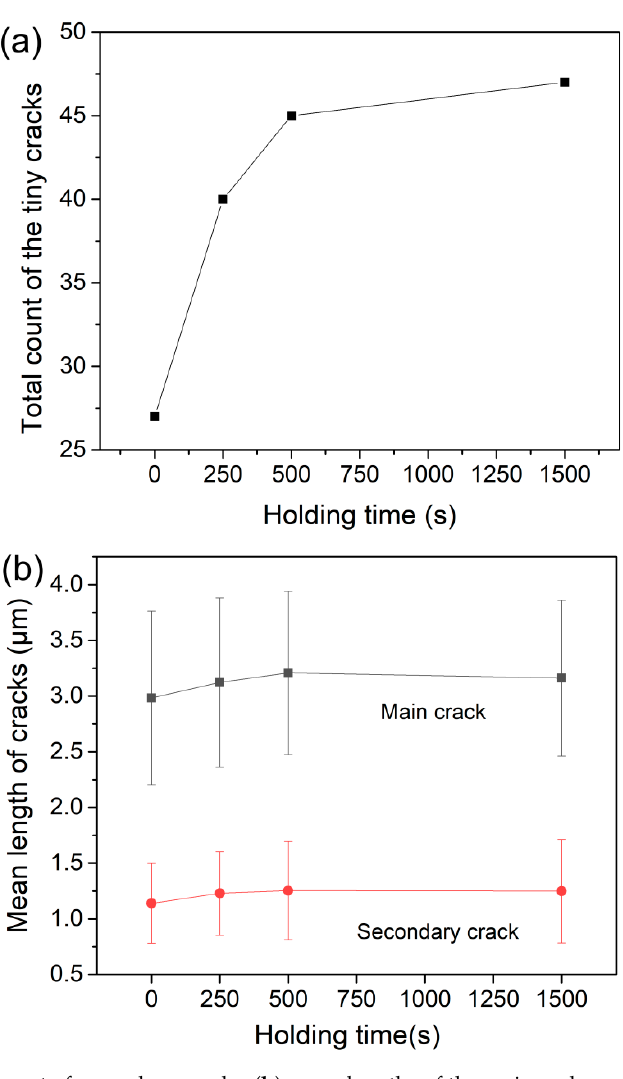
Figure 6. ( a ) Total count of secondary cracks; ( b ) mean lengths of the main and secondary cracks under different holding conditions.